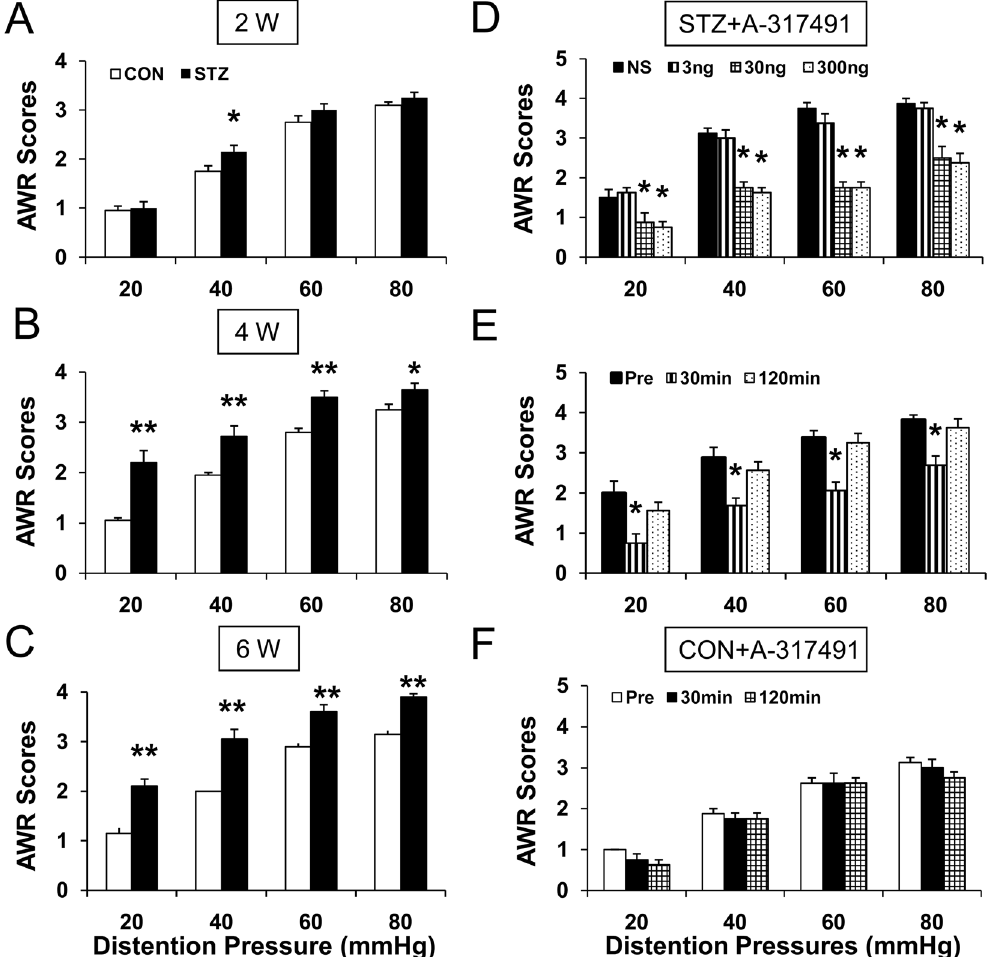
Figure 1. Colonic hypersensitivity in diabetic rats and inhibitory effect of P2X3 receptor antagonist A-317491 on colonic hypersensitivity. ( A ) Abdominal withdrawal reflex (AWR) scores in response to colorectal distention (CRD) from STZ group (n = 10) was significantly higher than CON group (n = 10) at distention pressures of 40 mmHg 2 weeks after vehicle (CON) or STZ ( * p < 0.05, compared with CON, Friedman ANOVA). ( B , C ) AWR scores in response to CRD from STZ group (n = 10) were significantly higher than control (n = 10) at distention pressures of 20, 40, 60 and 80 mmHg 4 and 6 weeks after STZ or vehicle injection ( * p < 0.05, ** p < 0.01, compared with CON, Friedman ANOVA). ( D ) A-317491 at doses of 30 nmol/kg (n = 8) and 300 nmol/kg (n = 8) dramatically suppressed AWR scores while NS (n = 8) and A-317491 at 3 nmol/kg (n = 8) had no significant effect on AWR scores ( * p < 0.05, compared with NS, Friedman ANOVA). ( E ) 30 min after administration of A-317491 at the dose of 30 nmol/kg resulted in a significant reduction on AWR scores of diabetic rats at 20, 40, 60 and 80 mmHg distention pressures, and the effects cleared away at 120 min after A-317491 treatment (n = 8, * p < 0.05, compared with Pre, Friedman ANOVA). ( F ) A-317491 at the dose of 30 nmol/kg did not produce any effect on AWR in CON rats (n = 6, p > 0.05, compared with Pre, Friedman